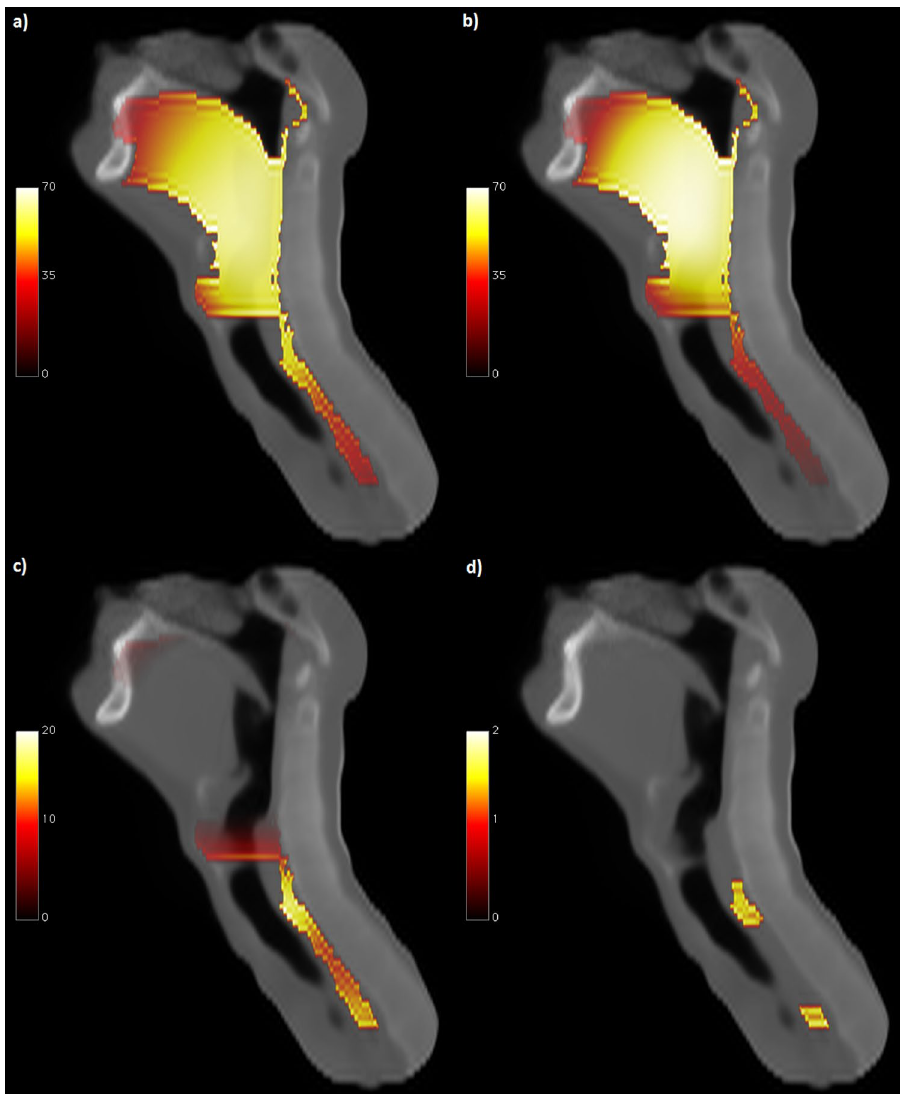
Figure 3. Dose distribution differences. Sagittal view of: mean dose map (Gy) for patients ( a ) who experienced radiation-induced acute dysphagia and ( b ) who did not; ( c ) corresponding dose difference map; ( d ) subregions showing a statistically significant dose difference between groups ( p < 0.05) according to TFCE permutation test (the color map represents -Log p